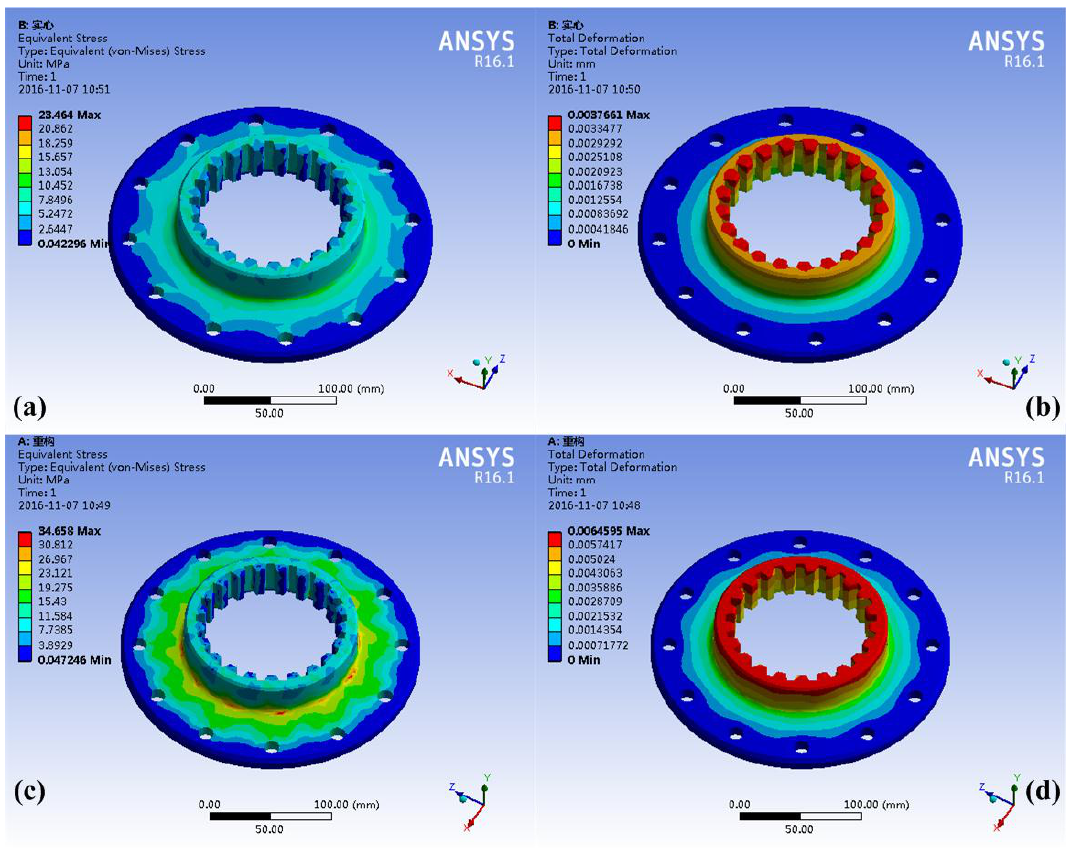
Figure 23. Stress distribution of original connecting plate ( a ), deformation of original connecting plate ( b ), stress distribution of redesigned connecting plate ( c ), deformation of redesigned connecting plate ( d